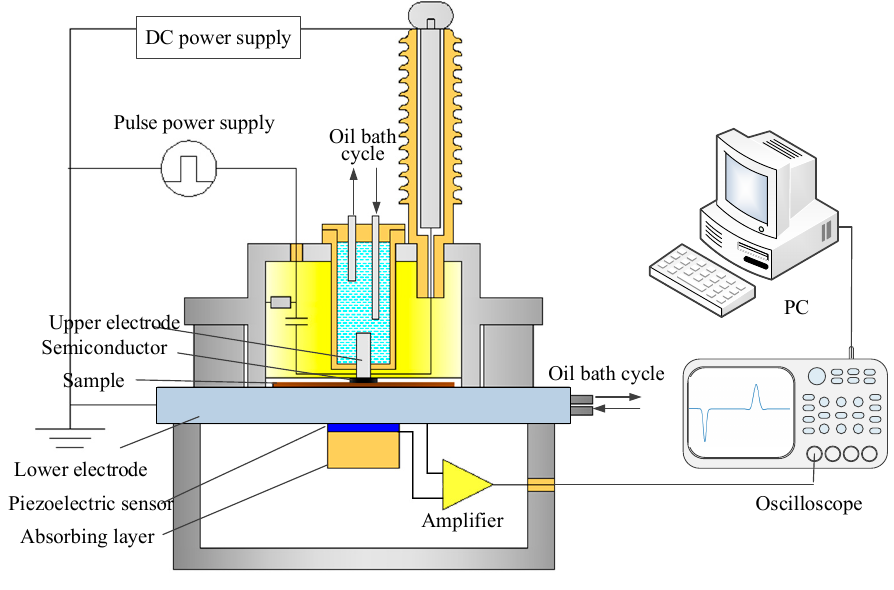
Figure 4. Schematic of space charge measurement system.